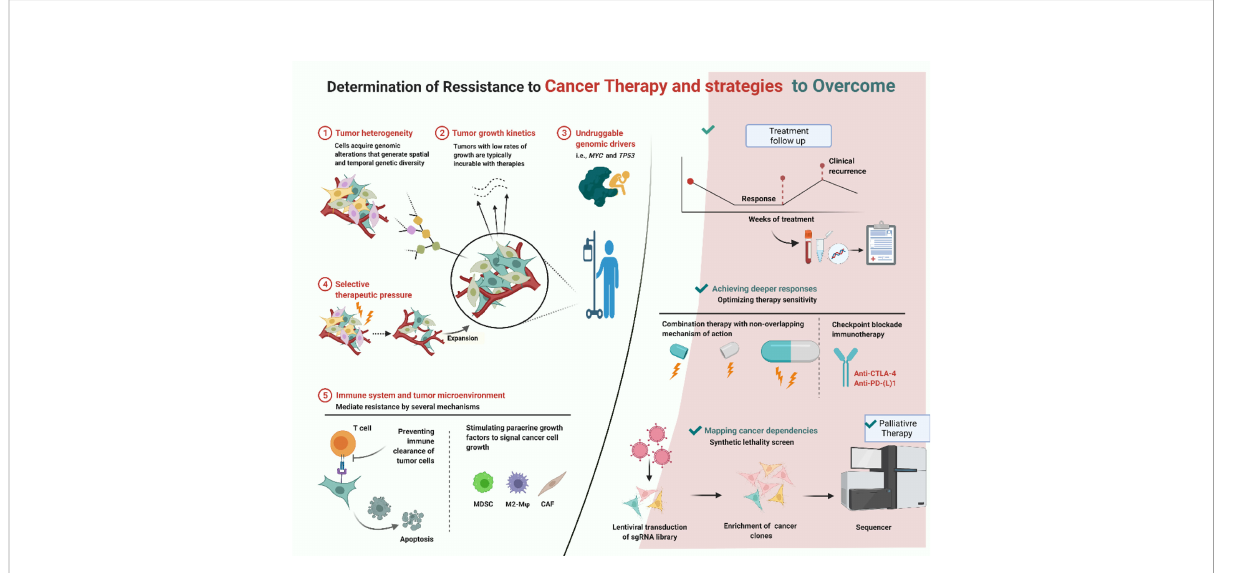
FIGURE 7 Stages of resistance development and therapeutic